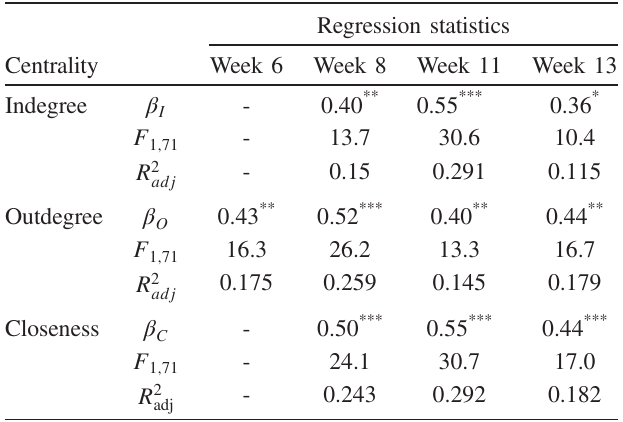
TABLE I. Linear regression results for the simple models (final grade ∼ centrality). Reported p values have been Bonfer- roni adjusted at the collection level. Significant p values are marked with the appropriate number of asterisks. Models in which centrality is not a significant predictor and models that failed the bootstrap test are omitted for clarity. This includes the entire week 2 and the betweenness centrality throughout the semester.